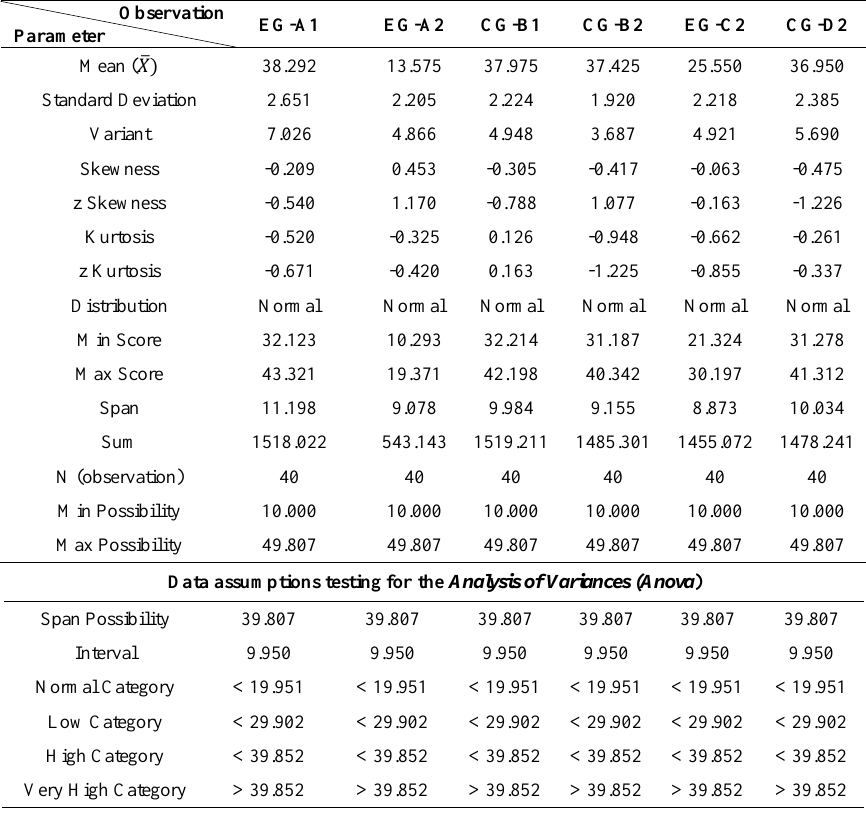
Table 2. Summary of Anxiety Variable's Descriptive Analysis on the EG and